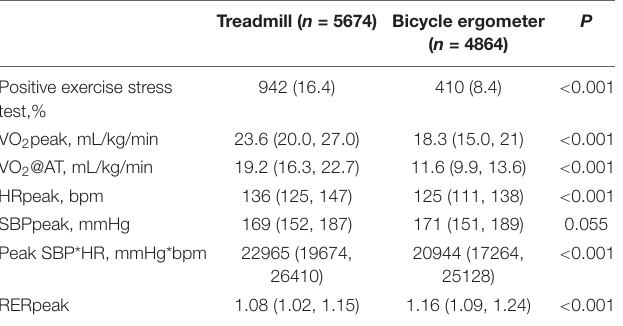
TABLE 2 | Comparison of the CPET results between the treadmill group and the bicycle ergometer group. Treadmill ( n = 5674) Bicycle ergometer ( n = 4864)